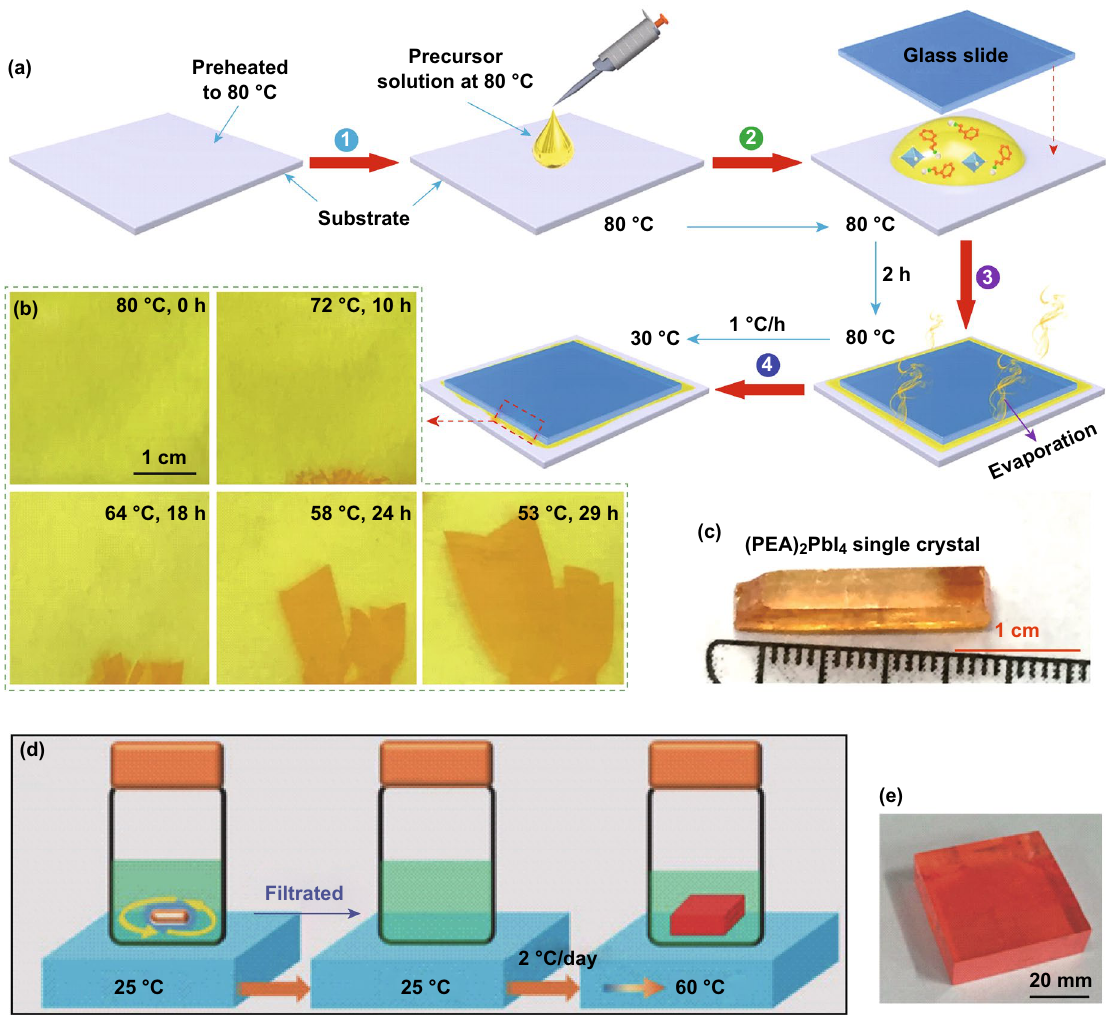
Fig. 4 a Schematic illustration of the IPC procedure. b Photographs of PEA 2 PbI 4 taken at different stages of the growth process. c Photograph of a typical